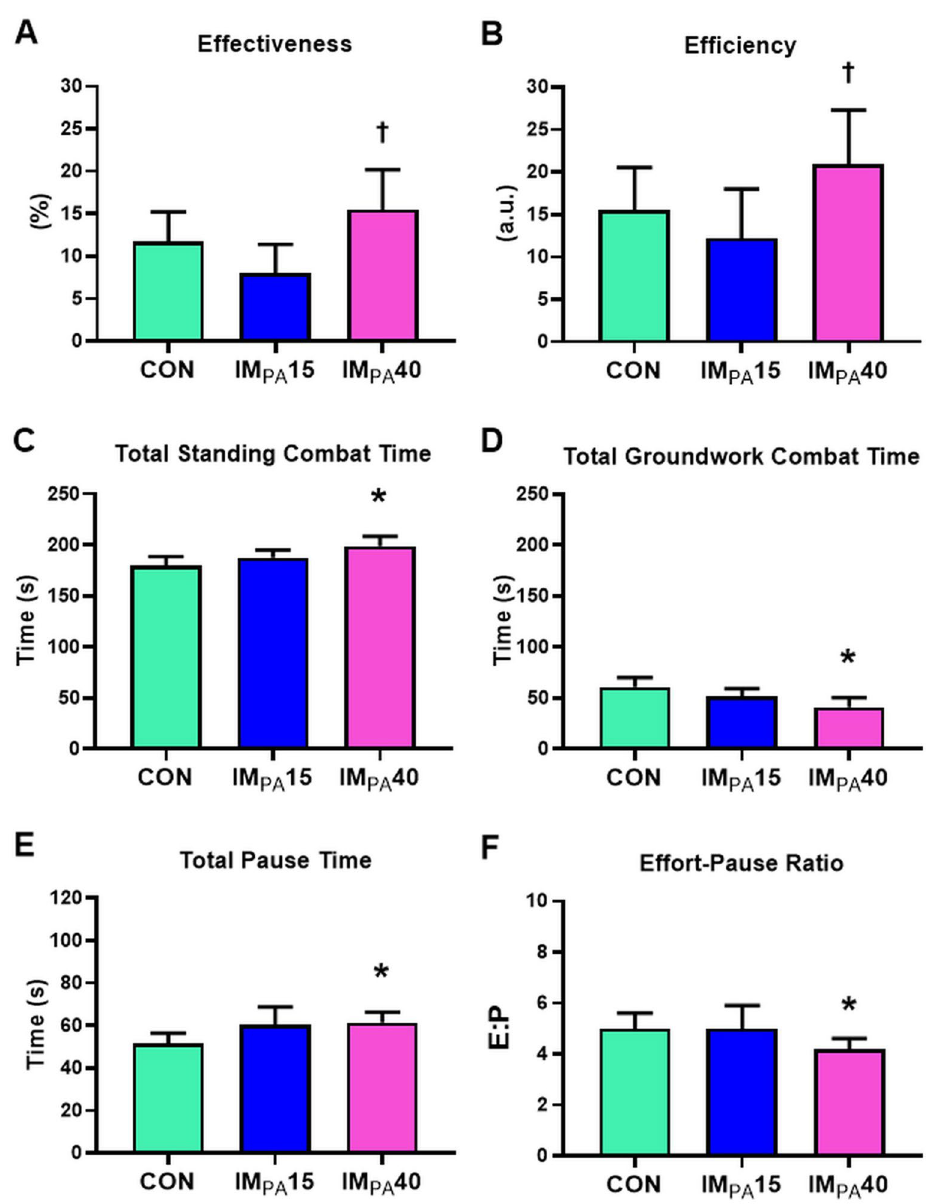
Figure 2. Technical-tactical parameters in the judo match. Results are presented as mean ± SEM. ( A ) Effectiveness (%); ( B ) Efficiency (a.u.); ( C ) Total Standing Combat Time (s); ( D ) Total Groundwork Combat Time (s); ( E ) Total Pause Time (s); ( F ) Effort-Pause Ratio (E:P). † Significant difference ( p ≤ 0.05) in comparison to IM PA 15. *Significant difference ( p ≤ 0.05) in comparison to